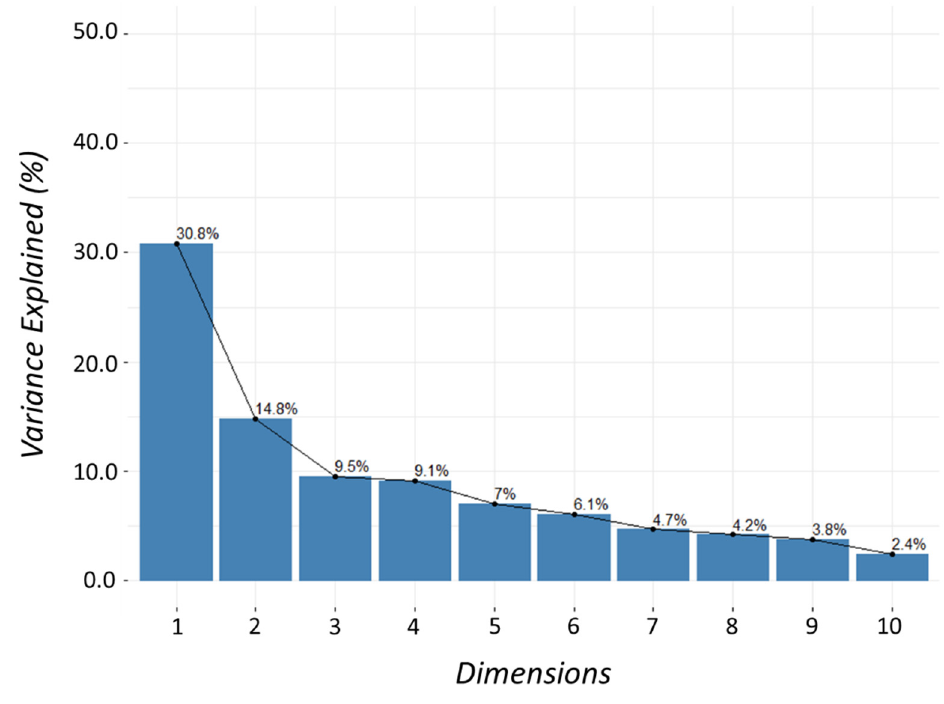
Figure 6. Scree plot produced from the principal component analysis of shad morphometric data containing one species term and 21 morphometric variables. Water 2020 , 12 , 701